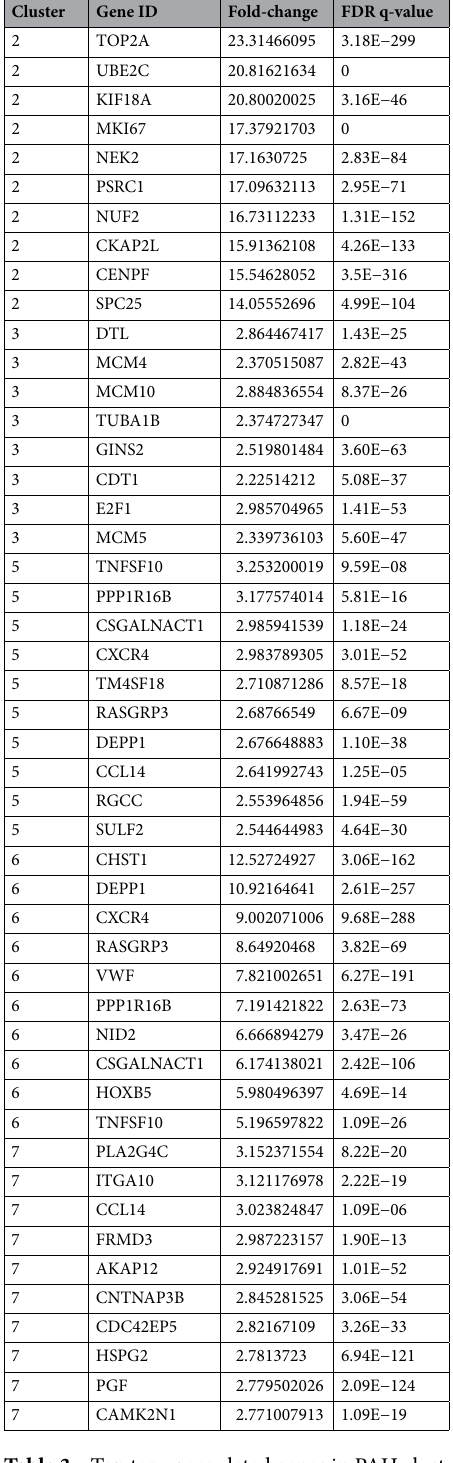
Table 3. Top ten upregulated genes in PAH clusters. Clusters 1 and 8 in PAH exhibited mostly down- regulated genes. Similar to control cluster 2, PAH cluster 2 overexpressed genes involved in cell proliferation. Interestingly, PAH cluster 3 was also enriched in overexpression of genes involved in cell proliferation ( cdt1 , DNA replication complex GINS protein ( gins2 ) , mcm10, mcm4, and mcm5 ). PAH cluster 4 did not have any upregulated genes. In cluster 5 contained genes reported in aberrant angiogenesis ( ccl14, cxcr4, rasgrp3 and Extracellular sulfatase Sulf-2 ( sulf2 )). Similar to control cluster 6, PAH cluster 6 was enriched in genes regulating immune cell—endothelial interaction and new vessel formation. Genes upregulated in PAH cluster 7 were compatible with an angiogenic phenotype (A-Kinase Anchoring Protein 12 (akap12); ccl14; pgf and Cell Division Cycle 42 Pseudogene 5